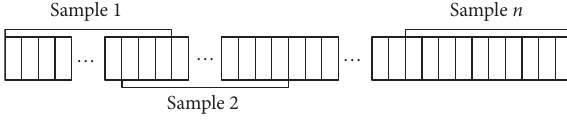
Figure 10: Data Table 3: Description of test data set.